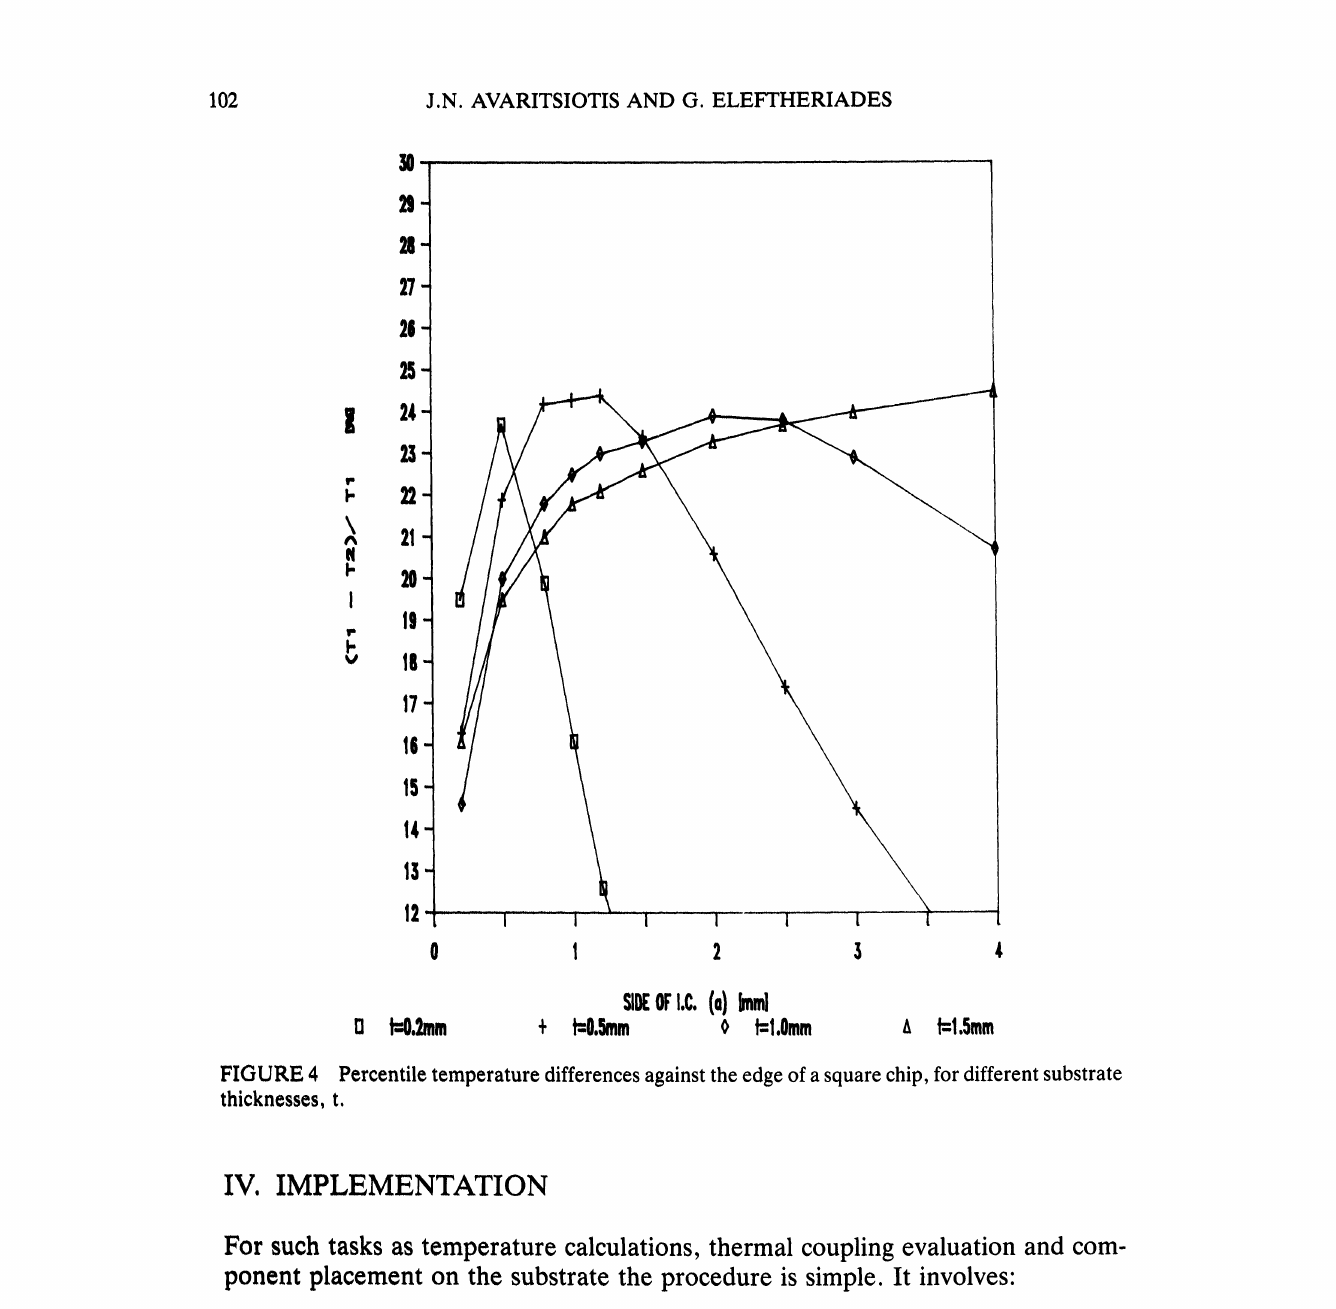
FIGURE 4 Percentile temperature differences against the edge of a square chip, for different substrate thicknesses,